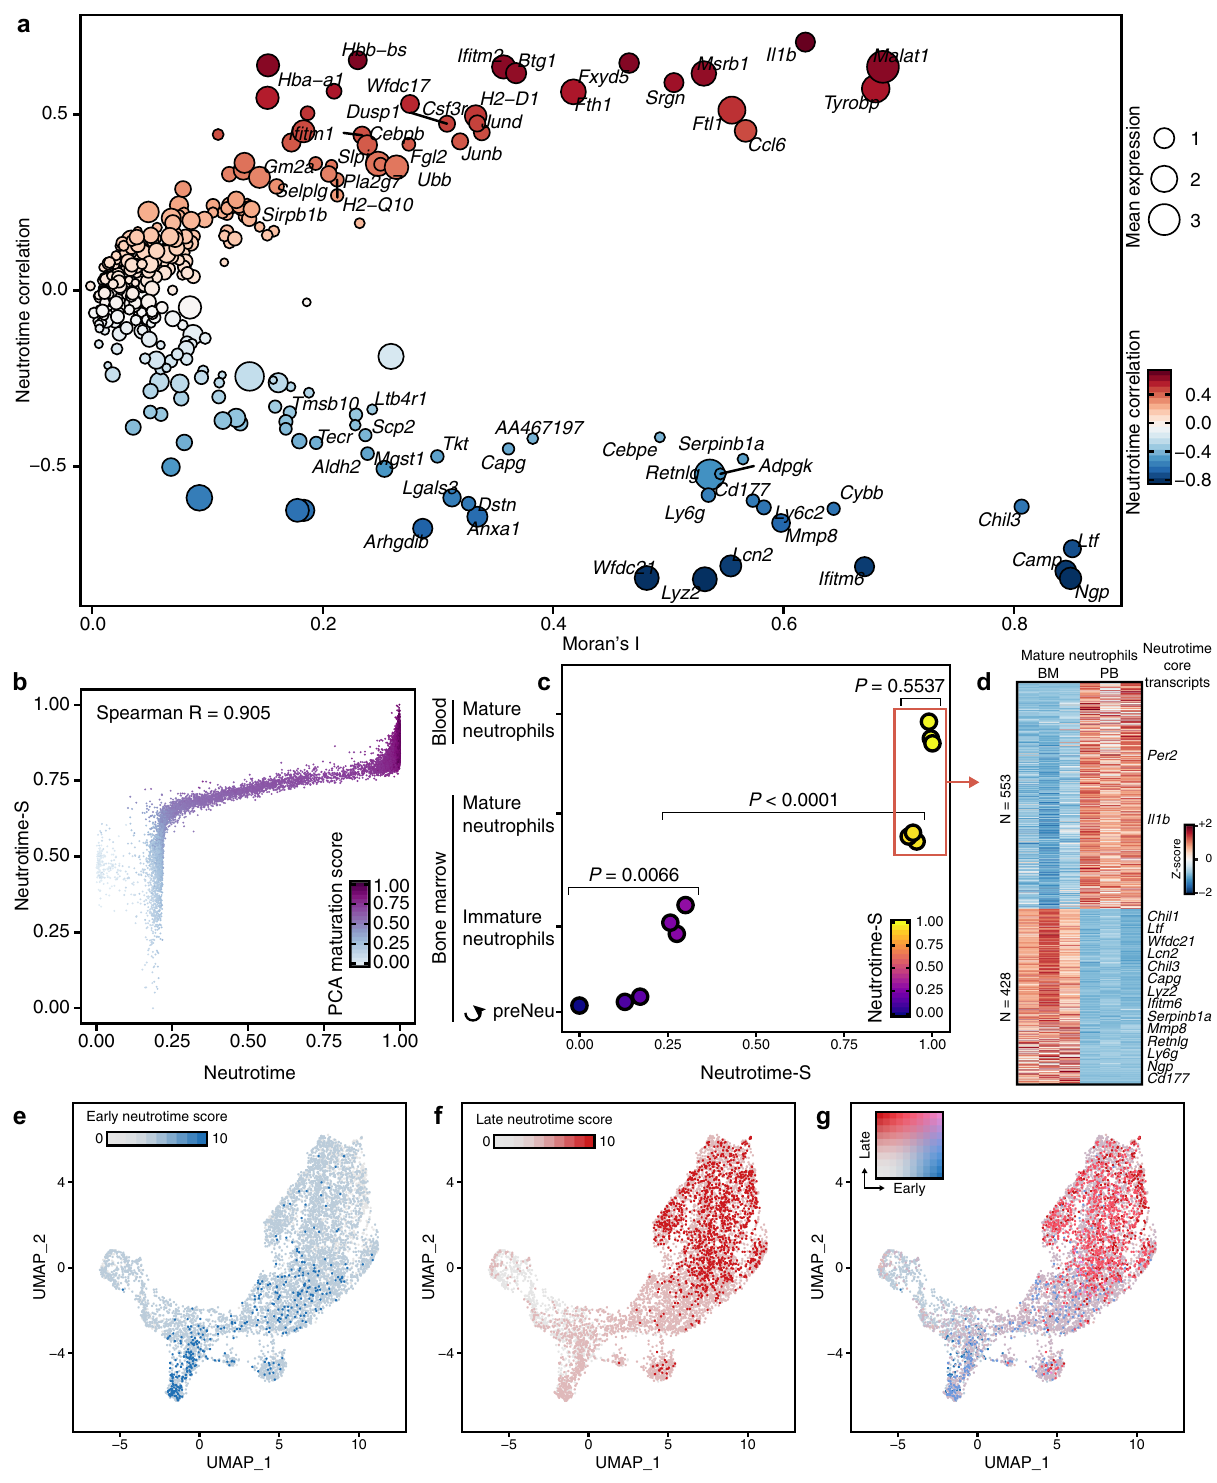
Fig. 5 Validation of the neutrotime model. a Spatial autocorrelation (Moran ’ s I) of genes calculated from a separately obtained dimensionality reduction using Monocle 3 plotted versus genes correlated with neutrotime. b Calculation of a simpli fi ed version of neutrotime directly from gene expression space yields high convergence with neutrotime. R indicates the Spearman ’ s rank correlation coef fi cient. c Integration of bulk RNA-seq data from developing and mature neutrophils from Evrard et al. (GEO:GSE109467) onto neutrotime-S. One-way ANOVA ( P < 0.0001) followed by Tukey ’ s multiple comparisons test. d Heatmap detailing differentially expressed genes between mature bone marrow neutrophils and blood neutrophils with Benjamin & Hochberg adjusted p -value (corresponding to FDR) ≤ 0.05 and log 2 fold change ≥ 1. Several core neutrotime transcripts are highlighted. e – g scRNA-Seq data were obtained from the Human Cell Atlas, and cells belonging to the neutrophil lineage ( N = 7049) were clustered together. Expression of an early ( e ) and late ( f ) neutrotime signature in neutrophils. g combined representation of early and late neutrotime scores in the Human Cell Atlas con fi rms the